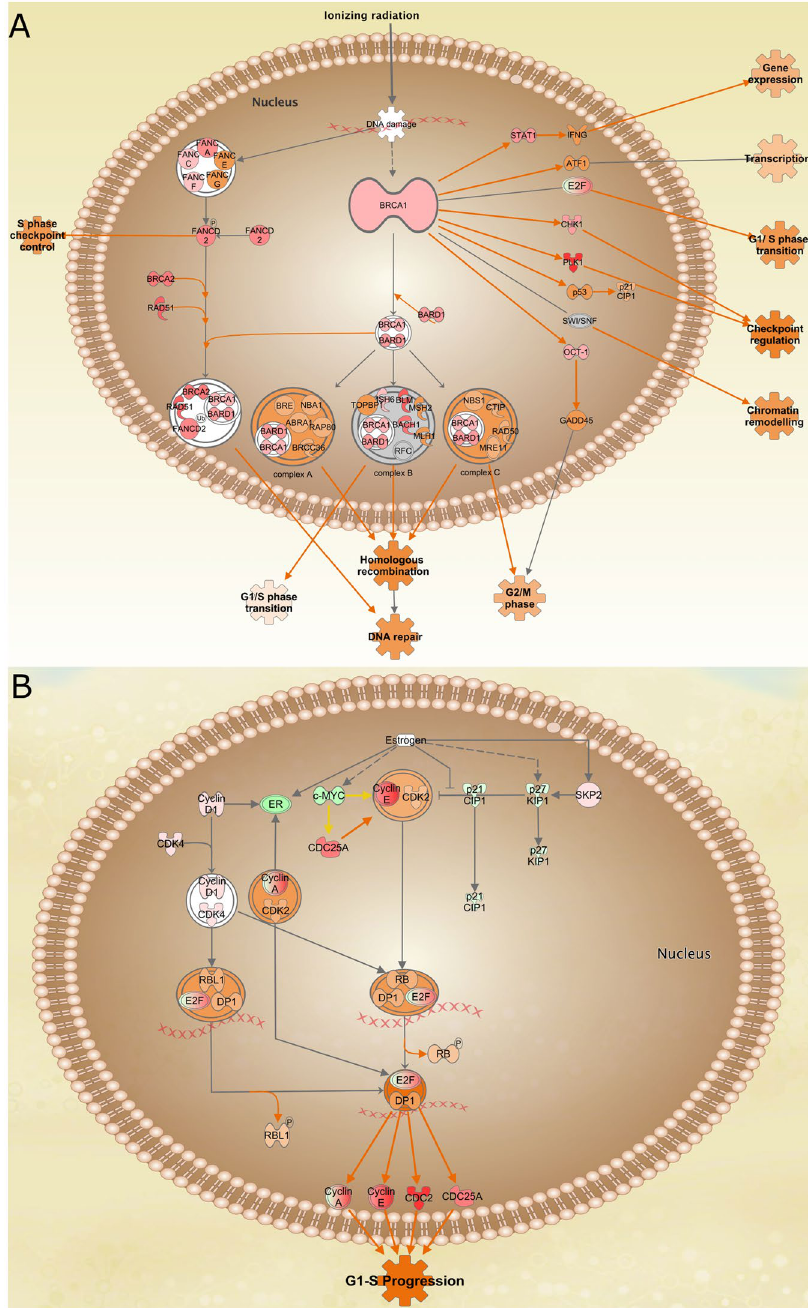
Figure 7. Top 2 activated canonical pathways. ( A ) Role of BRCA1 in DNA damage pathway. ( B ) Estrogen- mediated S-phase entry pathway. The molecules are depicted according to the standard color code of this manuscript. Notice that both pathways are consistent with cell cycle progression, a typical hallmark of